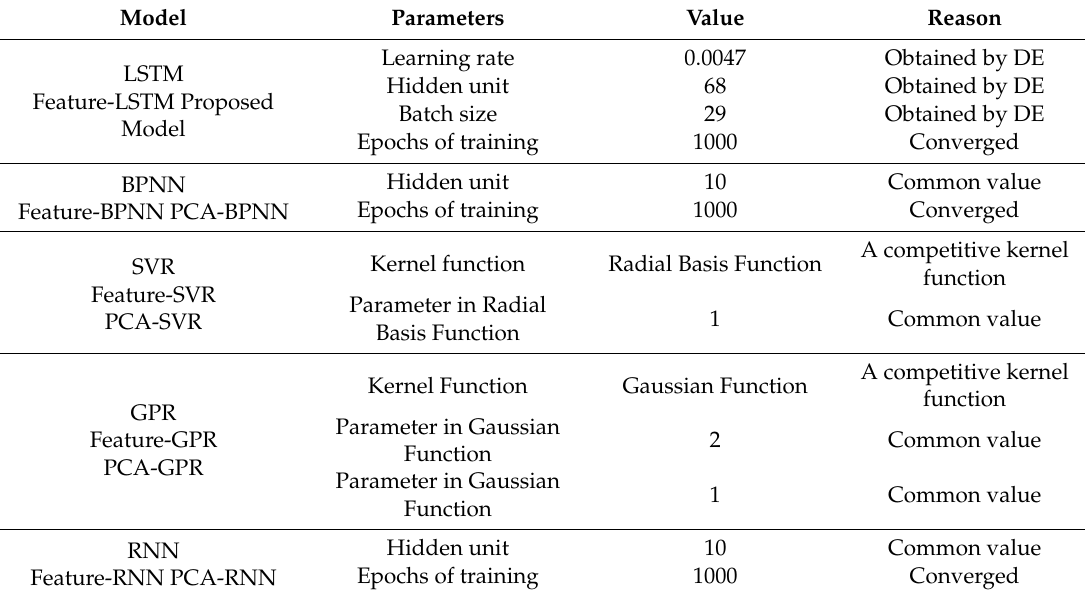
Table 3. Parameter settings.